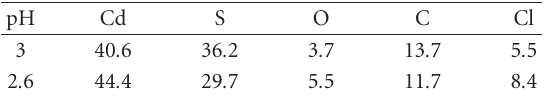
Table 2: Surface composition of CdS films prepared at pH 2 . 6 and 3.